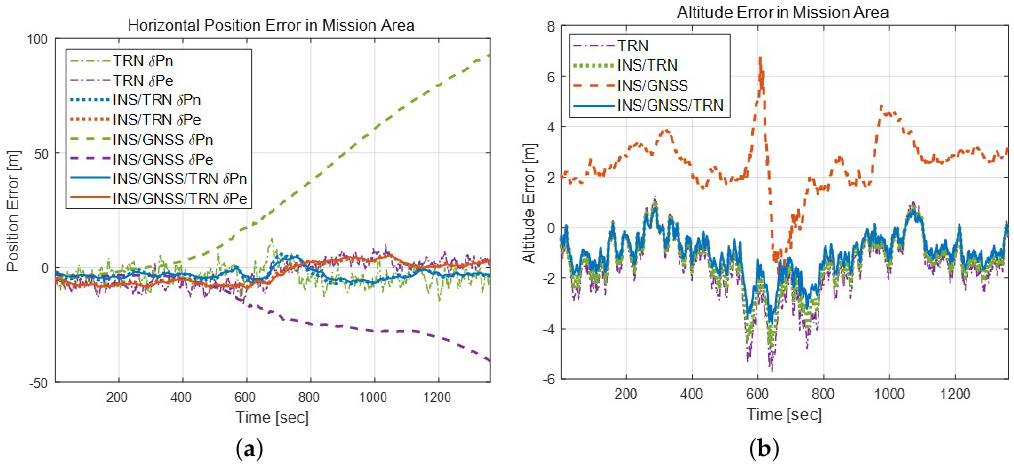
Figure 9. Results of SIL Test 2 when GNSS is unavailable in the mission area. ( a ) Horizontal position error. ( b ) Altitude